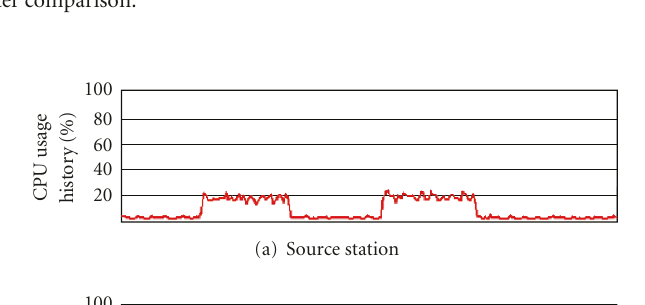
Figure 13: Jitter comparison.